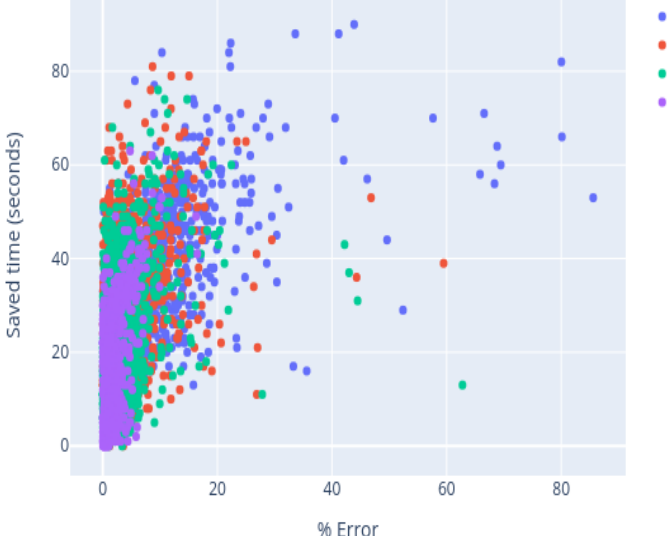
Figure 17. Saved time vs. error.